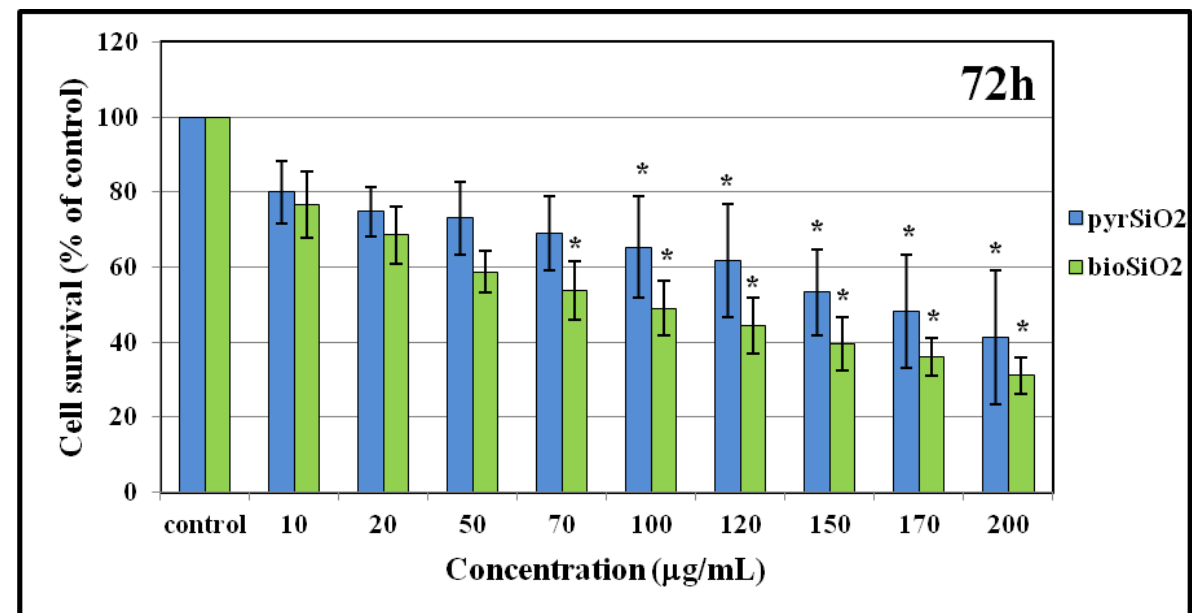
Figure 7. Cytotoxicity of HMEC-1 induced by silica nanoparticles. Cell survival of human dermal microvascular endothelial cell line of silica nanoparticles (pyrogenic and biogenic) was measured by MTT assay after 72 h exposure. Statistical evaluation of differences was made using the ANOVA I and Tukey’s post hoc test, at significance levels of p < 0.01 (*) with respect to control.